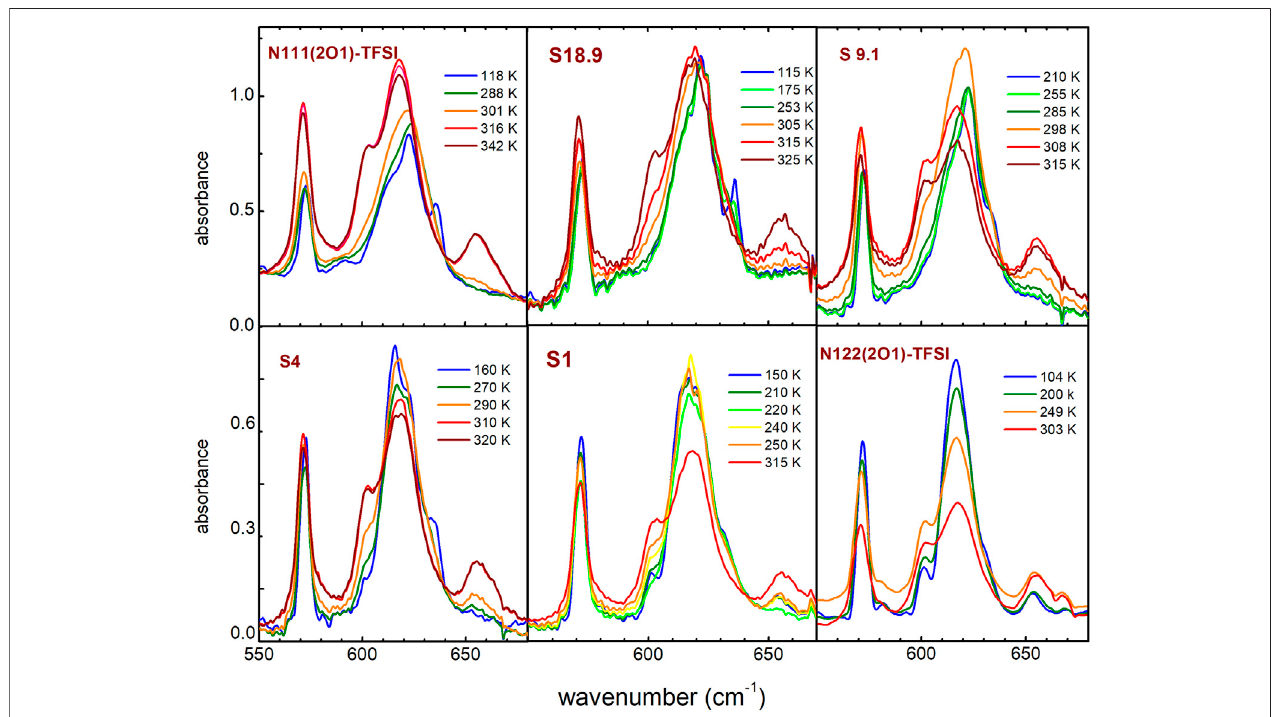
FIGURE 4 | Temperature dependence of the infrared absorption spectra of N111(2O1)-TFSI, N122(2O1)-TFSI and the four mixtures, measured on heating in the wavenumber range containing the markers of the cis and trans conformers of the anion.